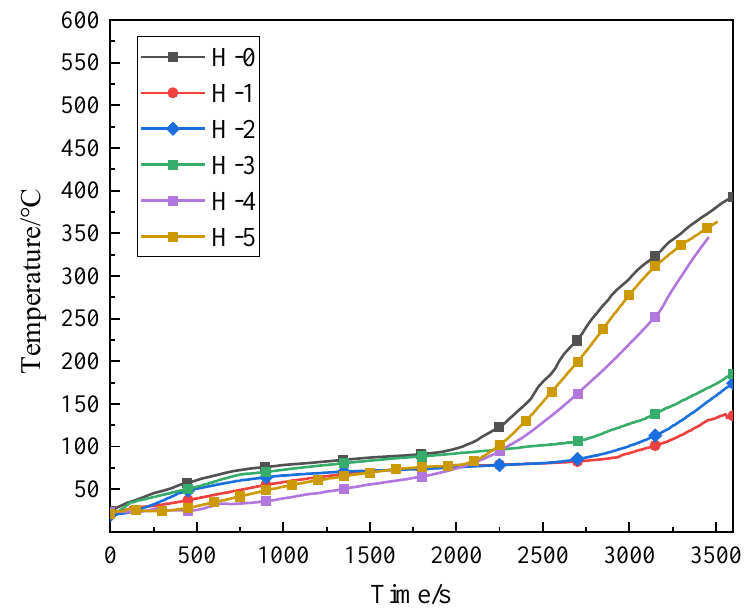
Figure 5. Backside temperature curves of the samples.